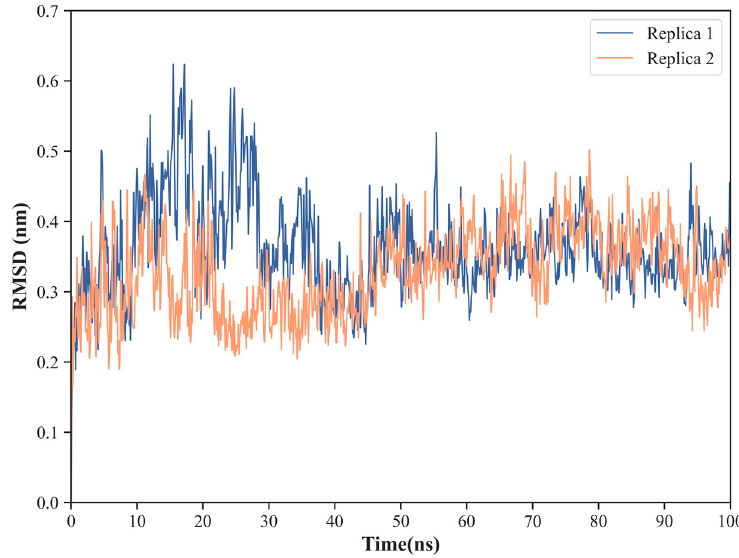
Figure 6. C α atoms root mean square deviation (RMSD) calculated over the MD simulation trajectories for the complex between the effector domain (ED) of NS1 and the iSH2 domain of the p85 β subunit of human PI3K (PDB ID: 6OX7).